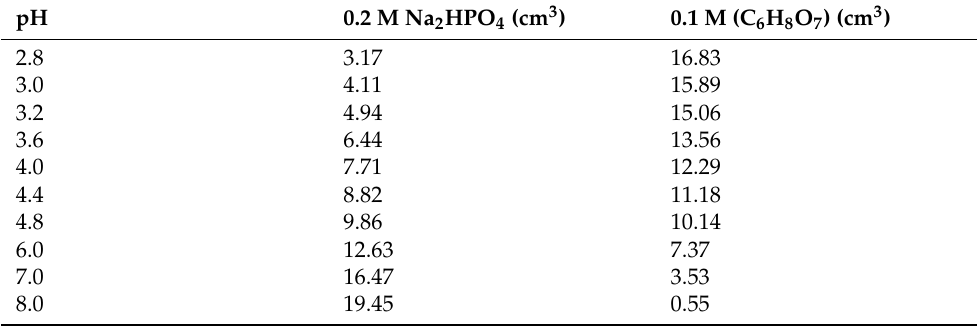
Table 2. Composition of the 20 mL buffer solutions used in the